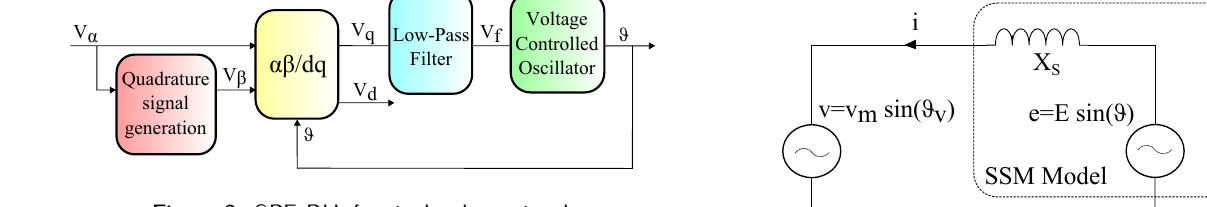
Figure 2. SRF-PLL for single-phase signals.